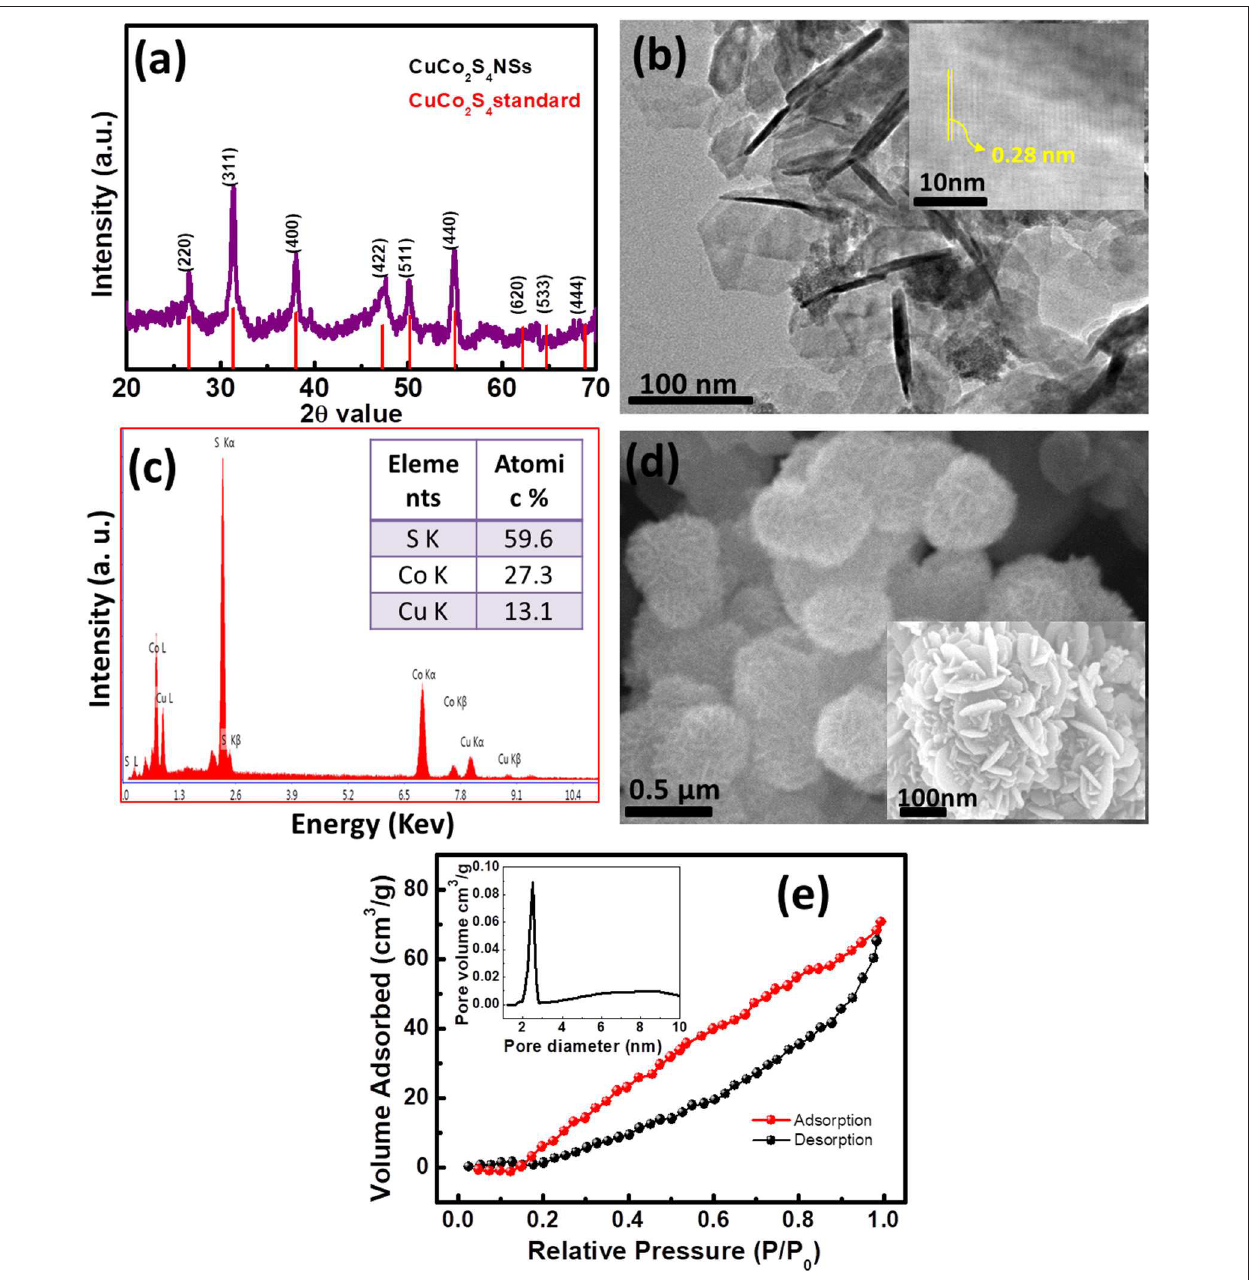
FIGURE 1 | (a) Powder XRD pattern of as-synthesized CuCo 2 S 4 nanosheets compared with the standard pattern, (b) Low-magnification TEM image, (Inset: HRTEM image), (c,d) SEM-EDS and FESEM imaging, respectively. (e) Nitrogen adsorption–desorption isotherms at 77K of the as-synthesized nanosheet sample. Inset: pore volume vs. pore size distribution of CuCo 2 S 4